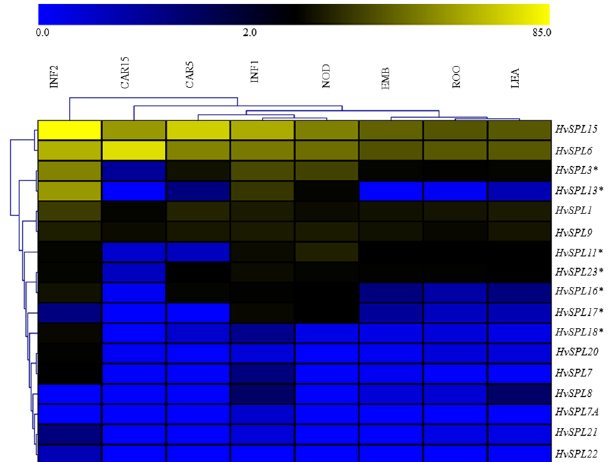
Figure 4. Spatio-temporal expression patterns of HvSPL genes in eight different tissues. The colour scale bar at the top of heat map represents FPKM normalized log2 transformed values based on “Morex” RNA-seq data, and represents high and low expression, respectively. EMB, ROO, NOD, LEA, INF1, INF2, CAR5 and CAR15tissues were used for expression profiling and indicated at the top of the heat map. Details about these tissues have been explained in material and method section. HvSPL genes that contain miR156 target sites are indicated by ( * ) asterisks